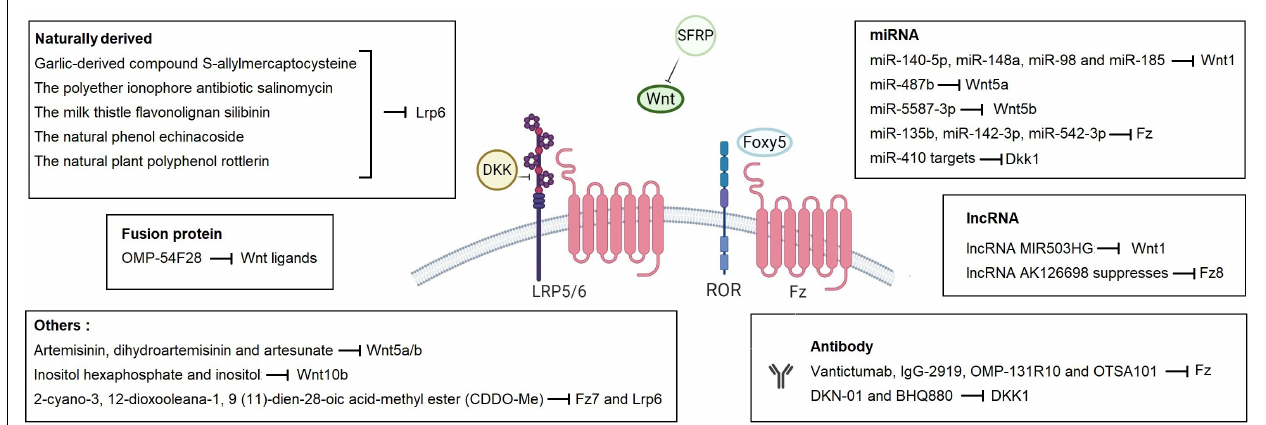
FIGURE 4 | Therapeutic molecules that target Wnt signaling pathway at the level of the plasma membrane. Different types of molecules are given with their target pathway component in boxes. Created with